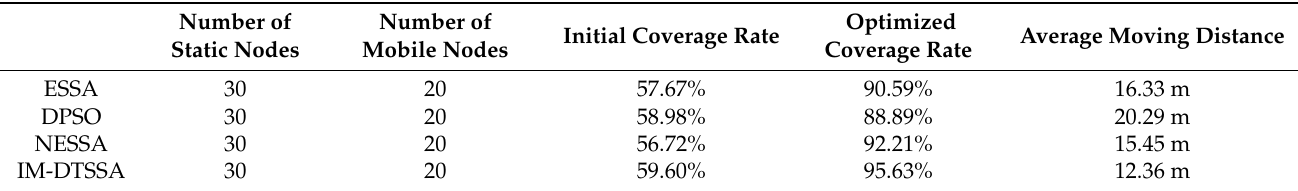
Table 1. Comparison of WSN performance in the area of 100 m × 100